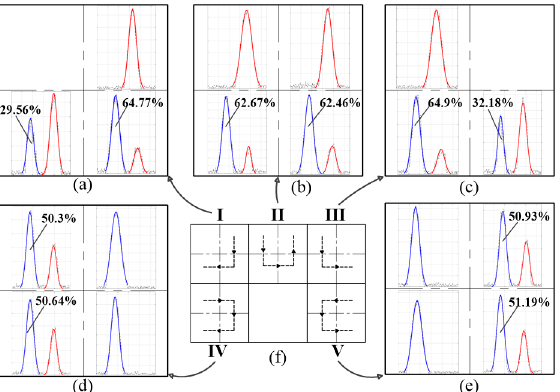
Figure 10. ( a ) The echo signal and PAET of each sub-region. ( b ) The depth image of the target with 5 × 5 pixels.